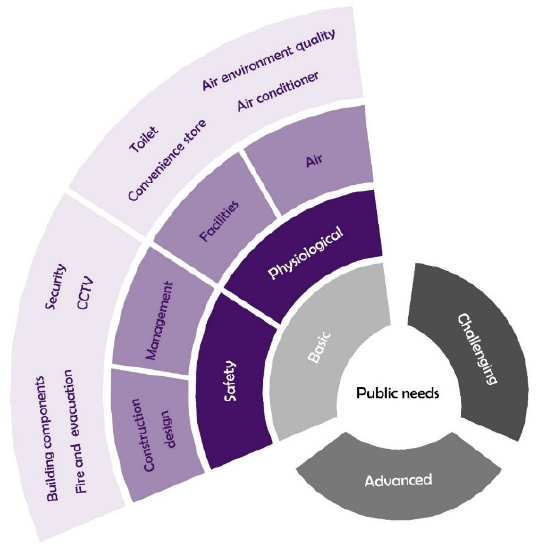
Figure 3. Measuring framework for basic needs (by author,